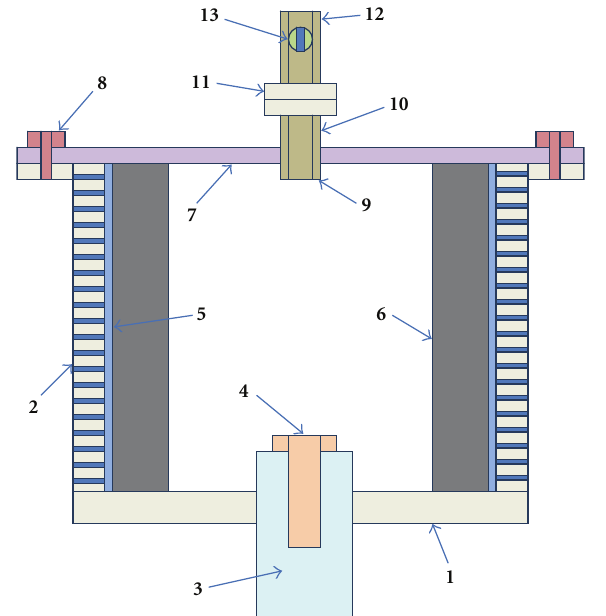
Figure 2: Schematic representation of the novel centrifuge with air pressure: (1) vessel, (2) circular holes, (3) rotor of the centrifuge, (4) lager screw, (5) a filter cloth, (6) filter cake, (7) lid, (8) smaller screws, (9) air inlet tubing, (10) flat-polished surface, (11) double-bearing connector, (12) external compressed air line, and (13) on/o ff valve.